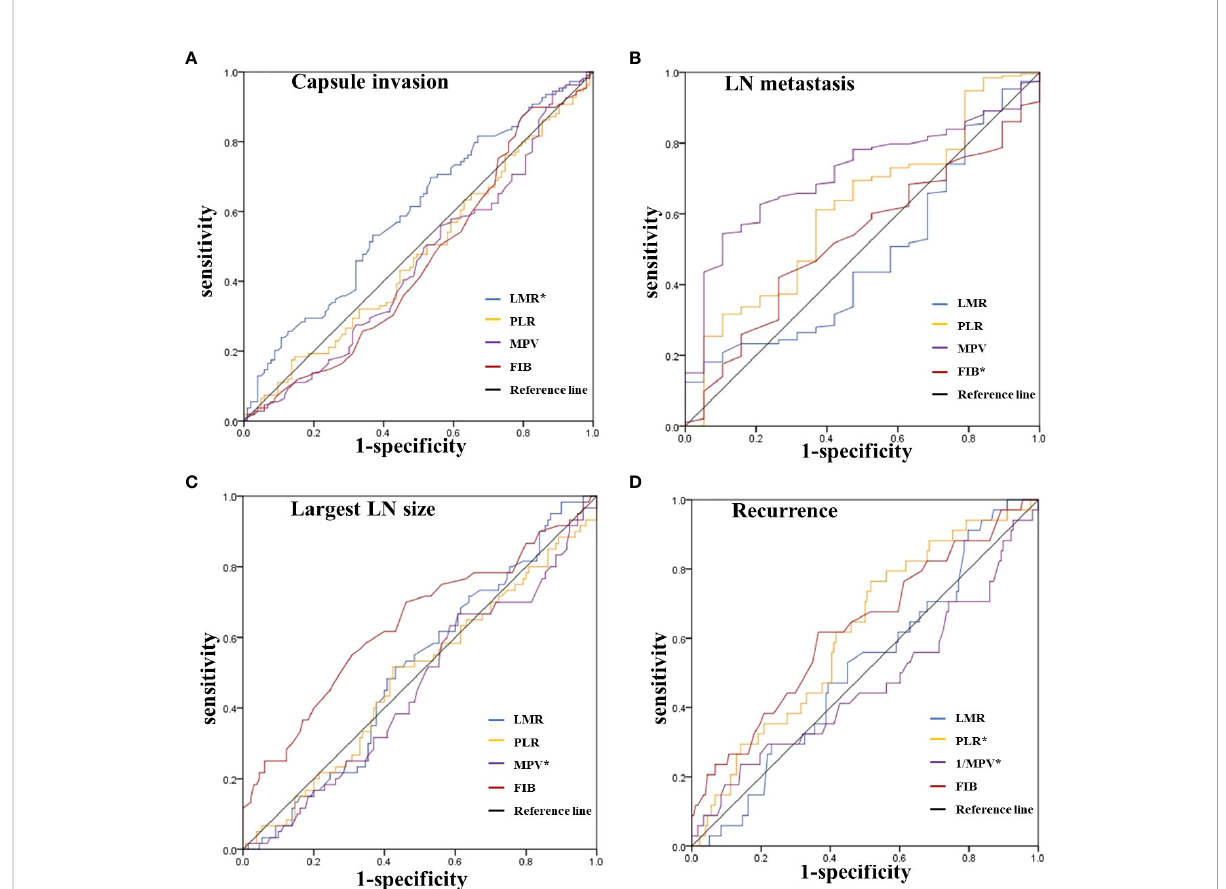
FIGURE 2 ROC curves for the preoperative LMR, PLR, MPV and FIB to predict (A) Capsule invasion, (B) LN metastasis, (C) Largest LN size, and (D) Recurrence in intermediate-high risk PTC patients. *Statistically signi fi cant P-values ( P < 0.05). LMR, lymphocyte-to-monocyte ratio; PLR, platelet-to-lymphocyte ratio; MPV, average platelet volume; FIB, fi brinogen; LN, lymph node; PTC, Papillary thyroid